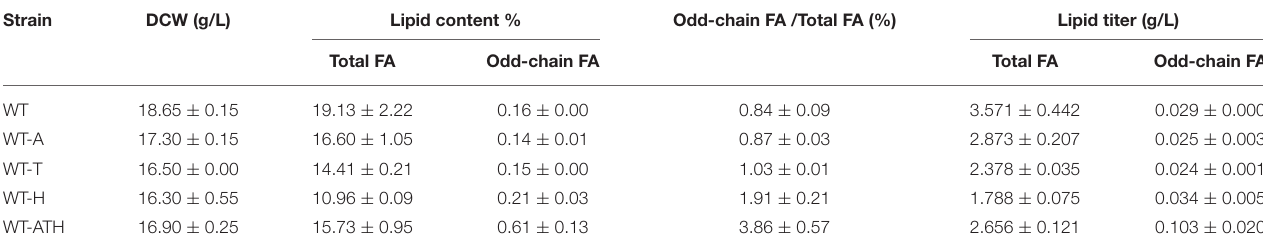
TABLE 2 | Fatty acid (FA) production in the wild-type (WT) strain and the engineered strains after growth on YNBD6 medium for 120h. Strain DCW (g/L) Lipid content % Odd-chain FA /Total FA (%) Lipid titer (g/L) Total FA Odd-chain FA Total FA Odd-chain FA WT 18.65 ± 0.15